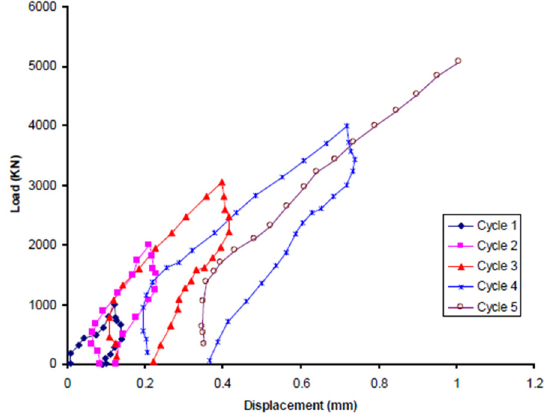
Figure 8. Load-displacement curves determined at a measuring point 60 cm below the loading plate.